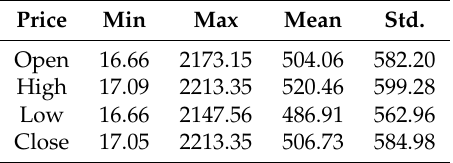
Table 2. Summary of S&P 500 index monthly prices from 1 March 1950 to 11 January